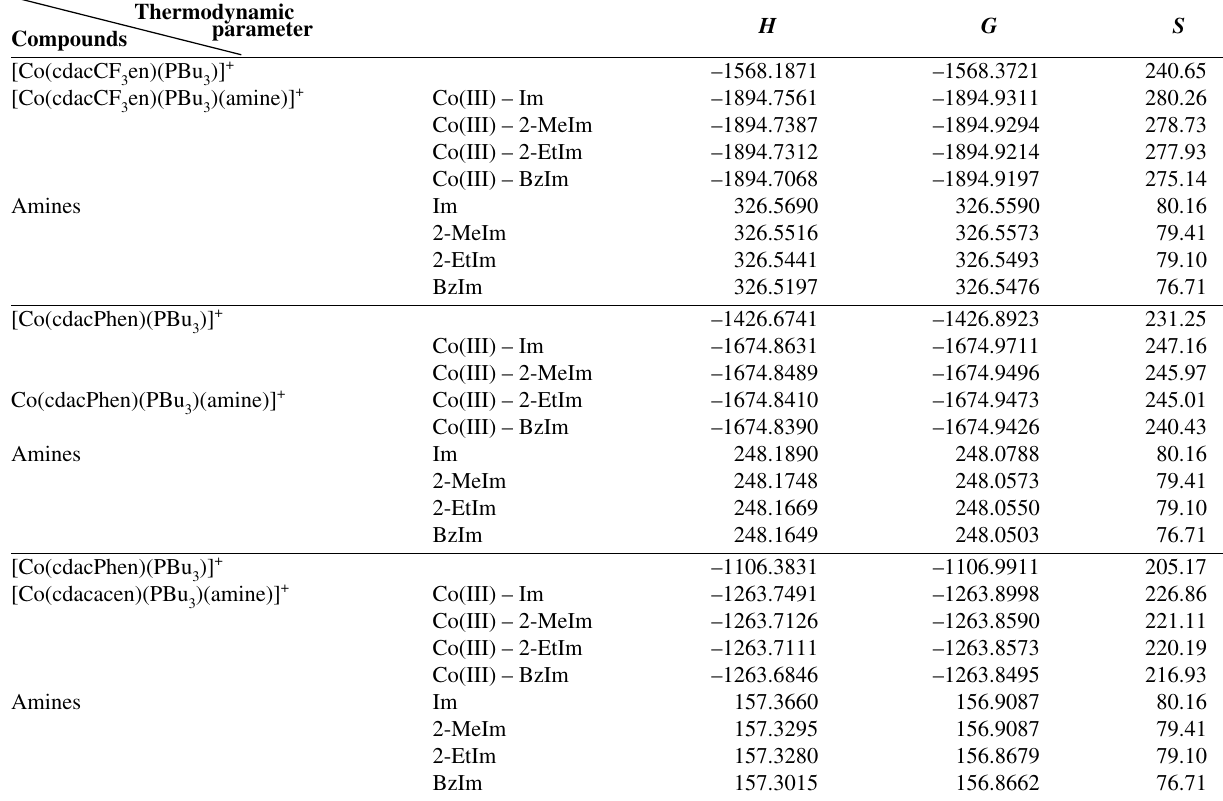
Table 5. The computational Thermodynamic parameter values, H /(Hartree), G /(Hartree) and S /J K –1 mol –1 for Co(III) Schiff base complexes, vari- ous cyclic amines and Co(III)-amines in gas phase. Thermodynamic